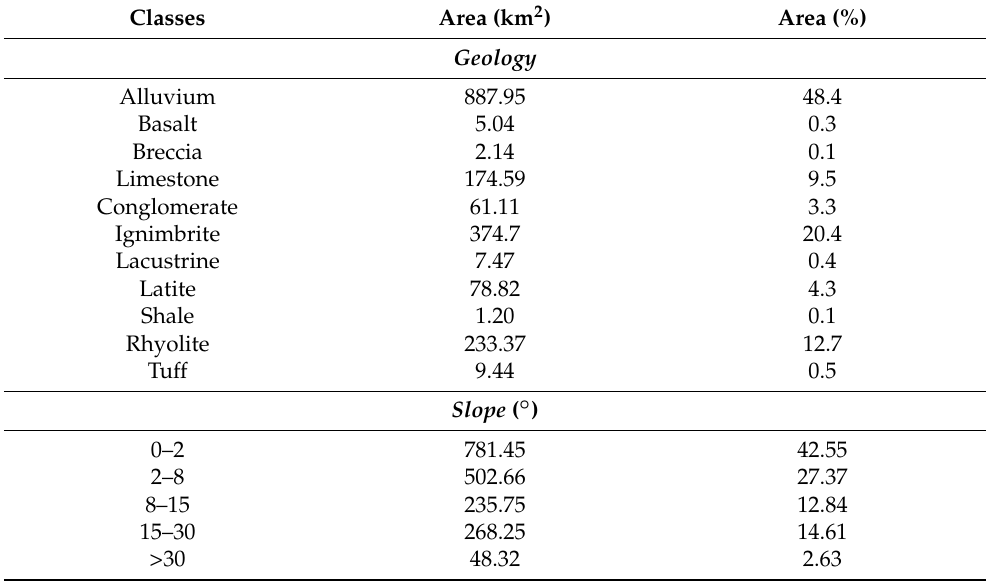
Table 6. Area coverage of each class for seven thematic